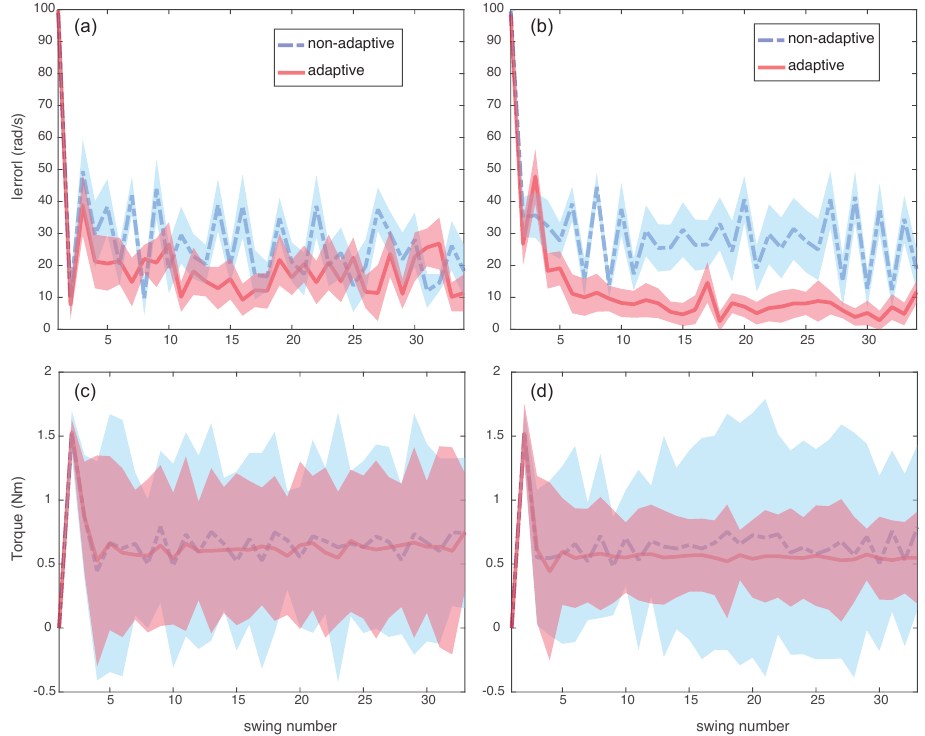
Figure 7. Comparing error and torque for five trials for the adaptive and non-adaptive controllers: ( a , c ) are for added mass of 0.3 kg; ( b , d ) are for added mass of 0.5 kg. The band shows one standard deviation for five trials and the line shows the